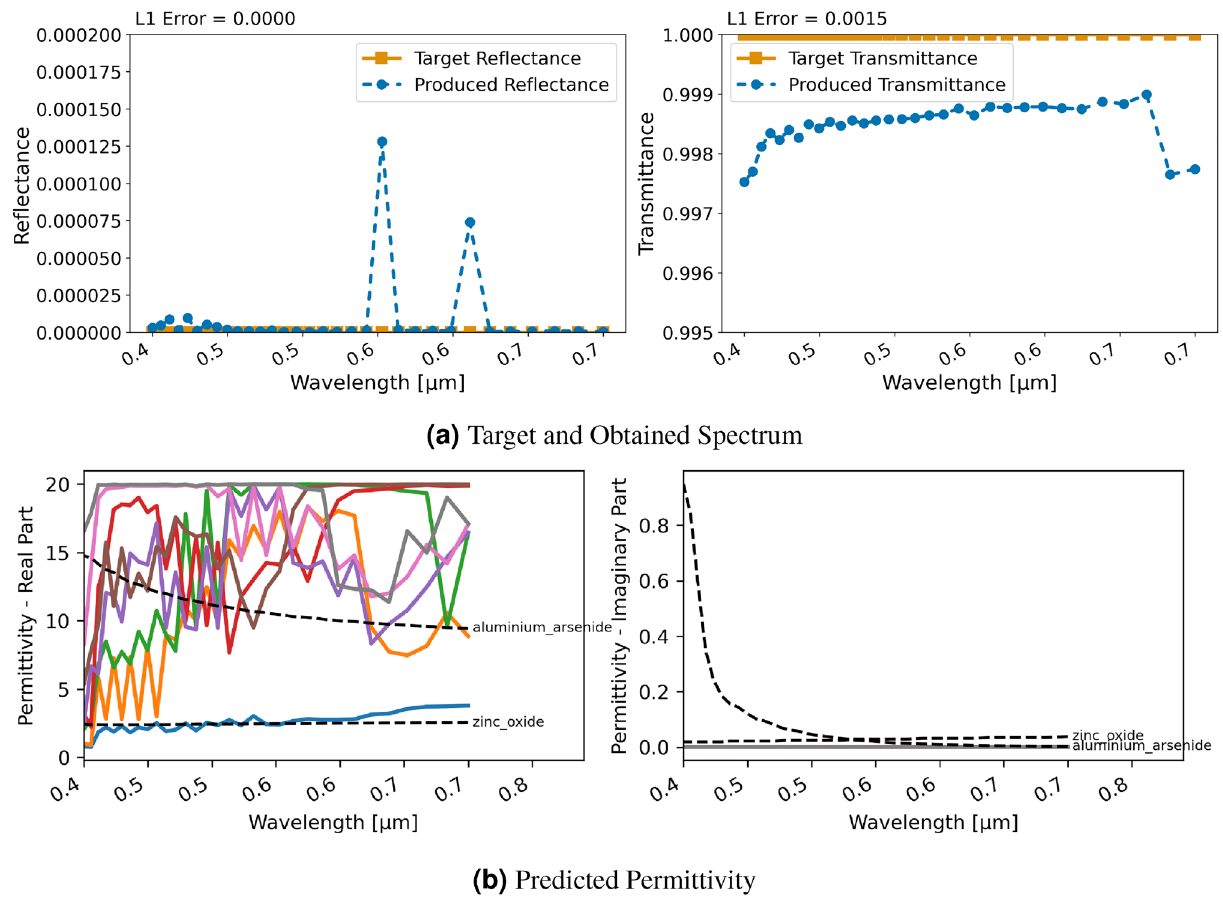
Figure 10. Inversion results for designing an anti-reflection coating with an eight layer stack using RCWA and regression; ( a ) displays target and produced spectra, ( b ) shows the utilized permittivity for each layer and closest material in NIDN